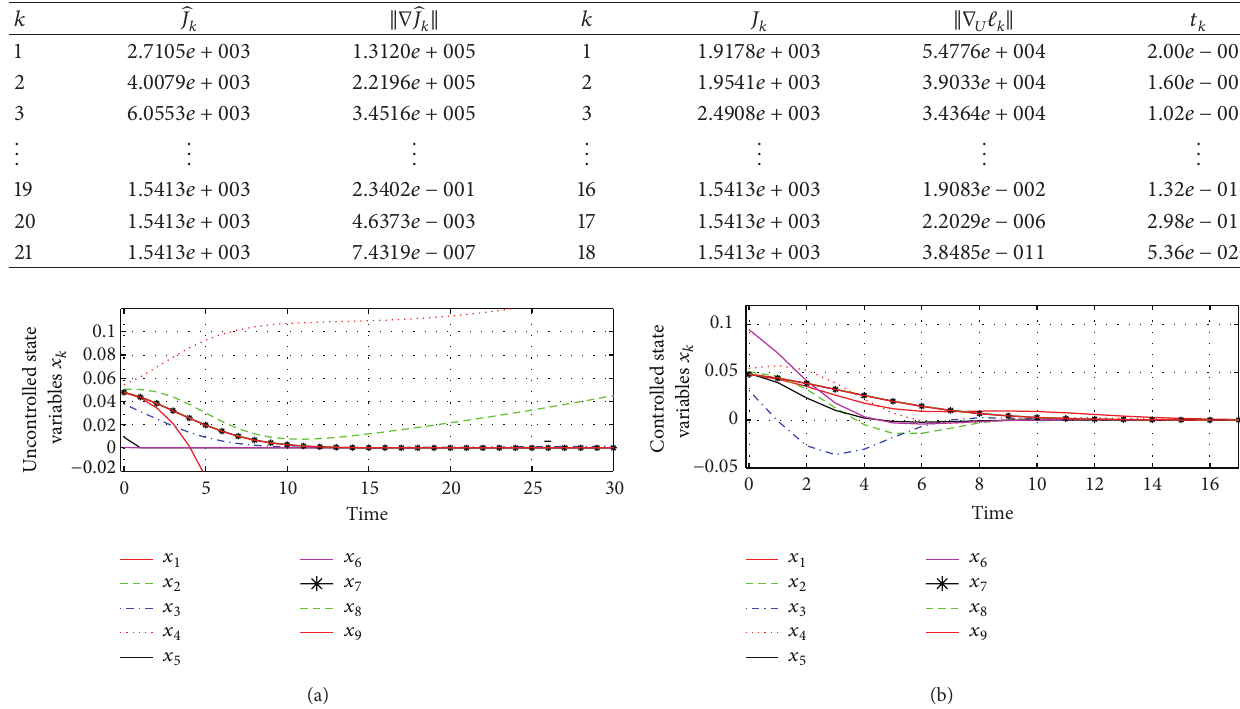
Figure 1: Open- and closed-loop systems for the aircraft model of Example 17.